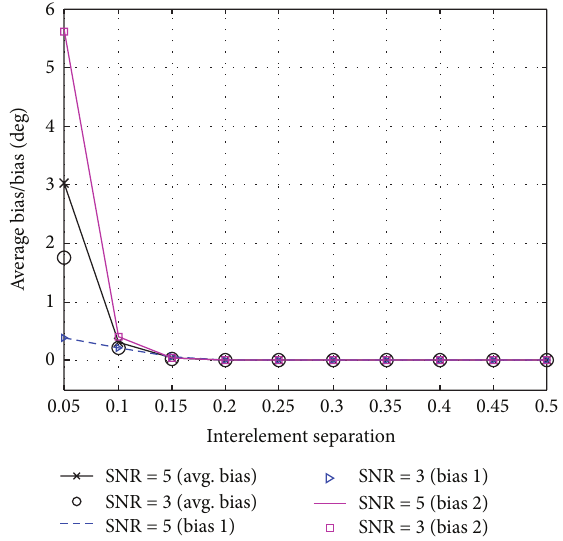
Figure 1: Summary of DOA estimations using MPM for a four- element ULA with interelement separation varying from 0.05𝜆 to 0.5𝜆 . Two equal-power incoming signals are from the directions of = 5 ∘ and 𝜙 = 6 ∘ with an SNR of 5dB and 3 dB, respectively. The 𝜙 1 2 graph shows (i) average bias of the estimated directions and (ii) bias of the estimation of signals 1 and